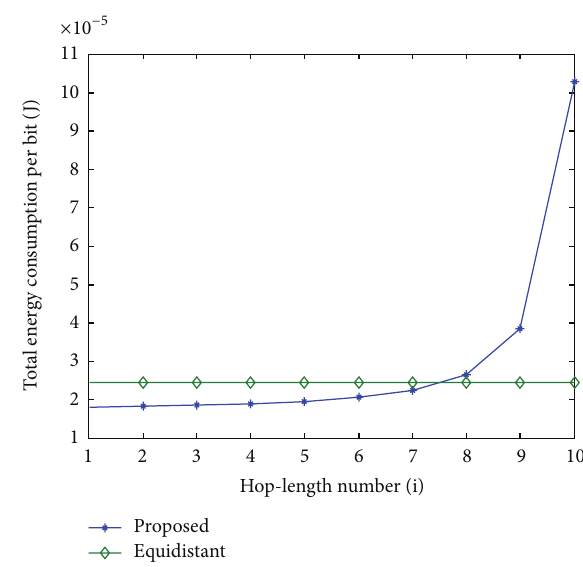
Figure 13: Total energy consumption per bit for each cluster, 3 bits transmission.